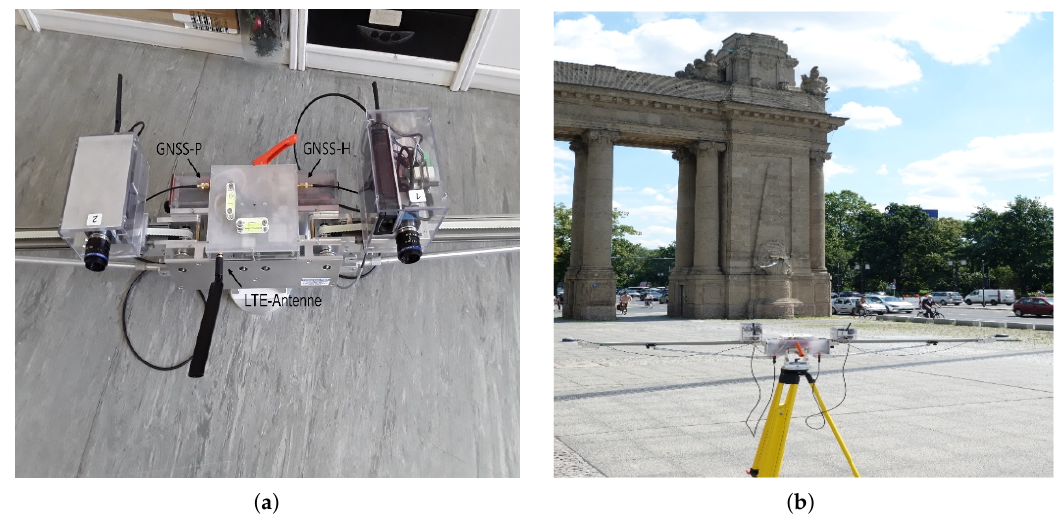
Figure 5. Point clouds acquisition: ( a ) Stereo cameras system, ( b ) Camera in action on the field during the scan of the data set “Charlottebürgerturm” in Berlin